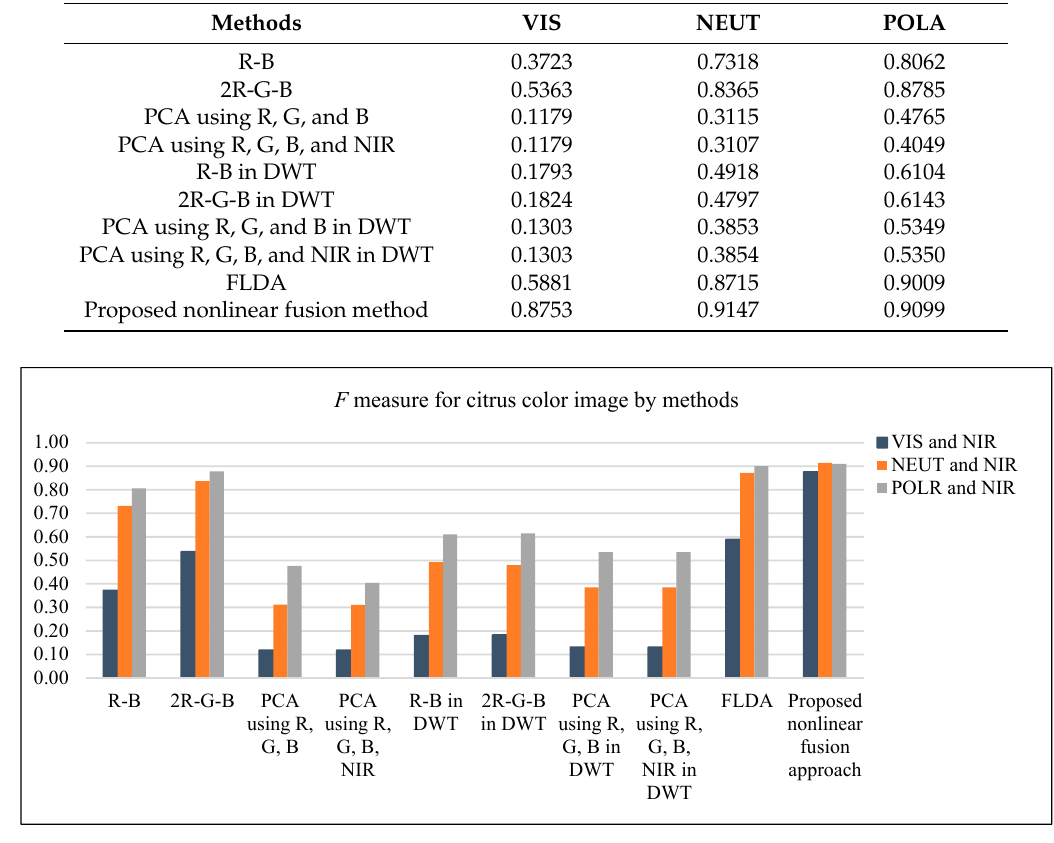
Table 3. F measure for classified results with different linear methods and nonlinear fusion method. F Measure by Methods ( α = 0.98–0.99)